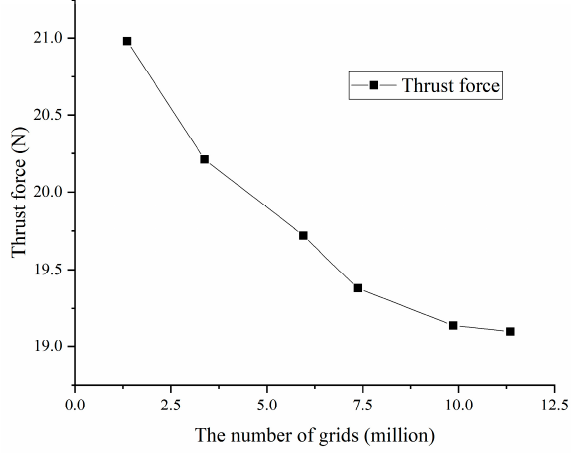
Figure 5. Mesh independence analysis.